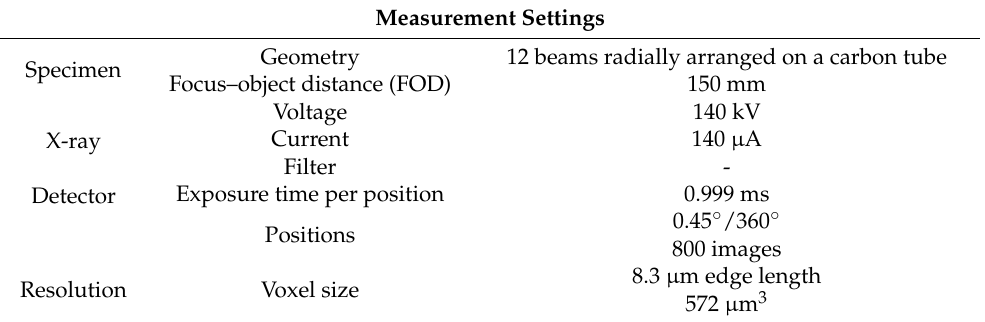
Table 2. Measurement settings employed for the micro X-ray computed tomography ( µ XCT) analyses. Measurement